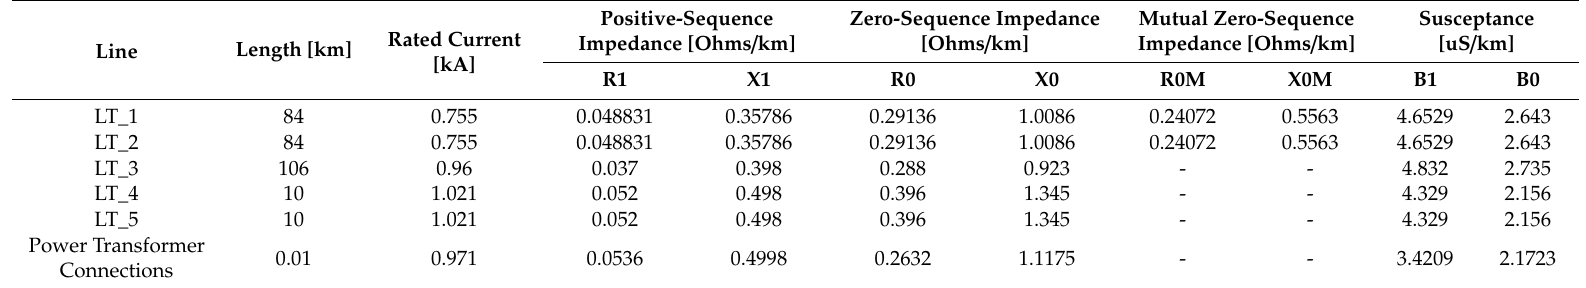
Table A3. Electrical parameters for the transmission lines used in the